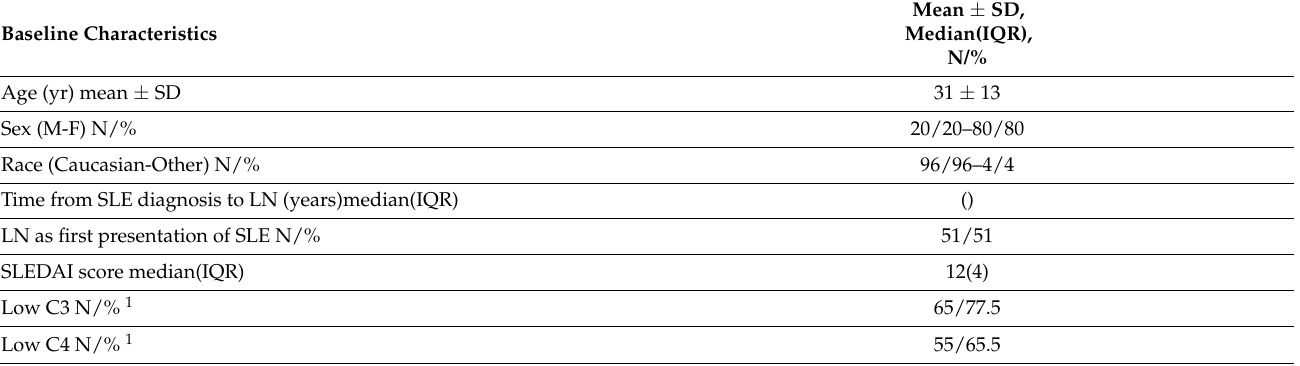
Table 1. Baseline demographic, clinical, laboratory and histological characteristics and immunosup- pressive treatment